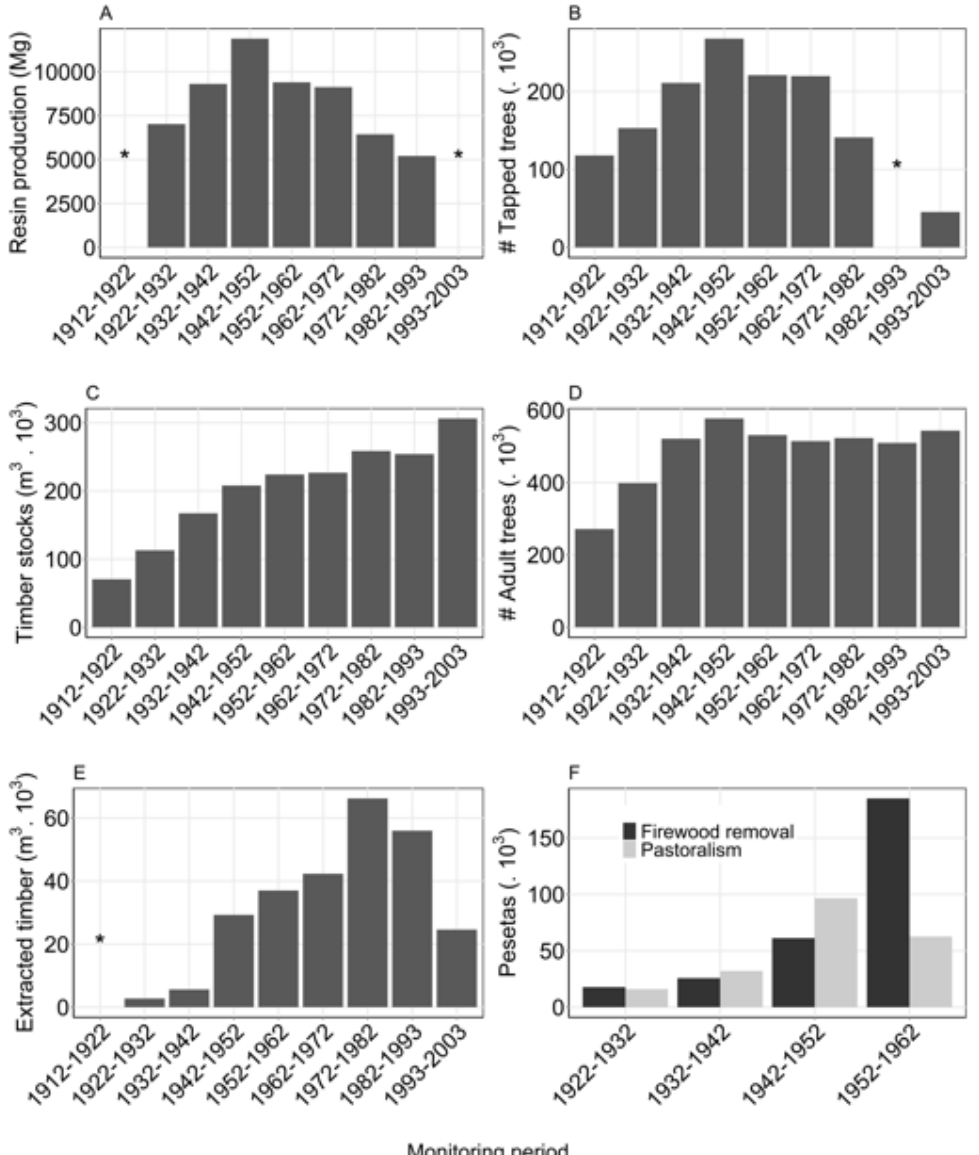
Figure 3. Evolution of resin production ( A ), number of tapped trees ( B ), standing timber stocks ( C ), number of adult trees (dbh > 20 cm) ( D ), extracted timber ( E ), firewood removal and pastoralism ( F ) in Las Pegueras Forest over the study period (1912–2003). Asterisks indicate data non-availability.